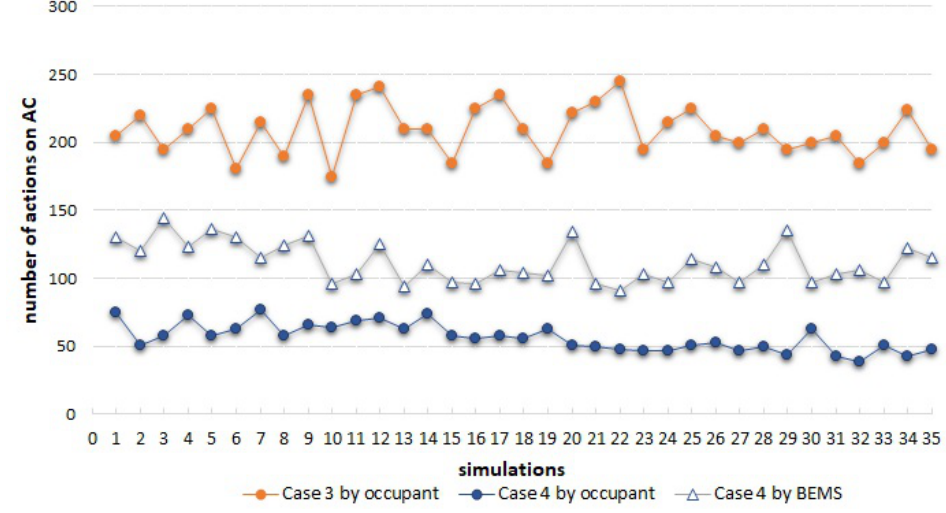
Figure 15. Number of actions for AC activation in Cases 3 and